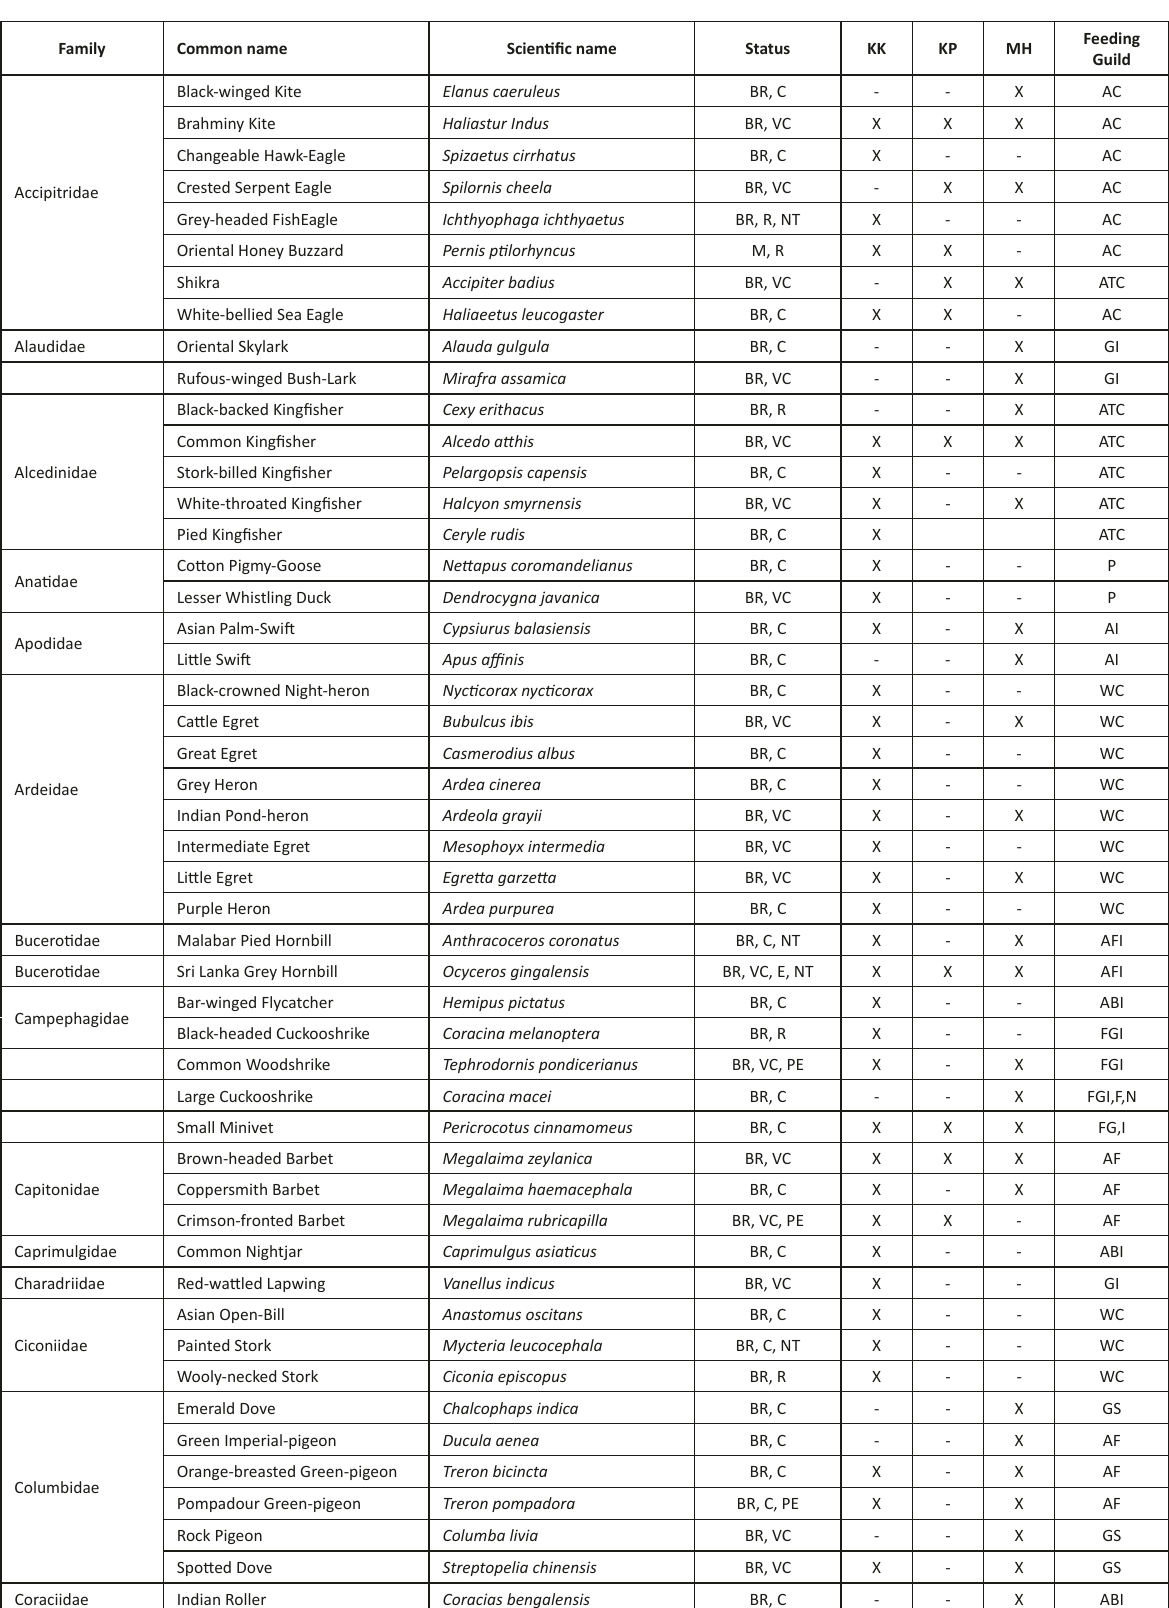
Table 1. List of Avifauna in Mihintale